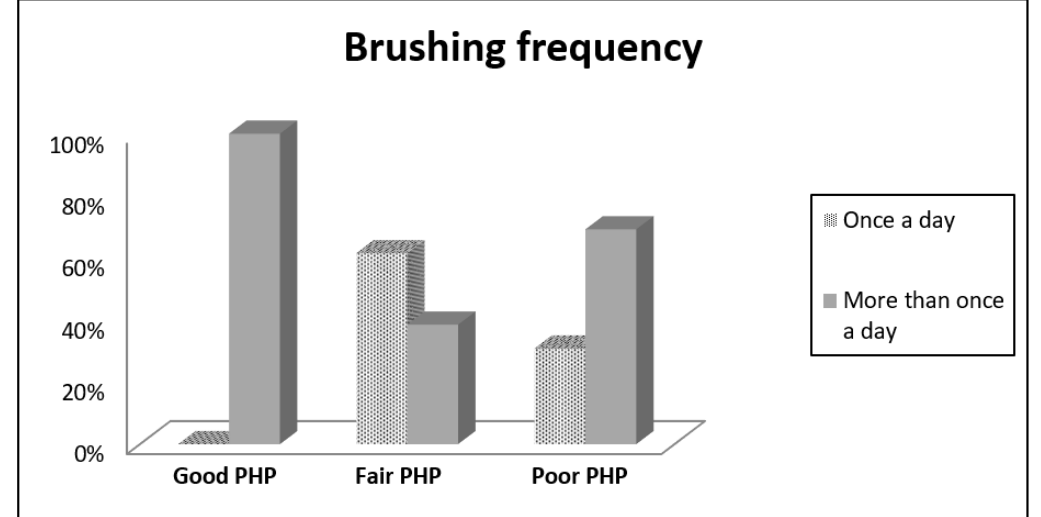
Figure 2. Descriptive statistics (brushing frequency).